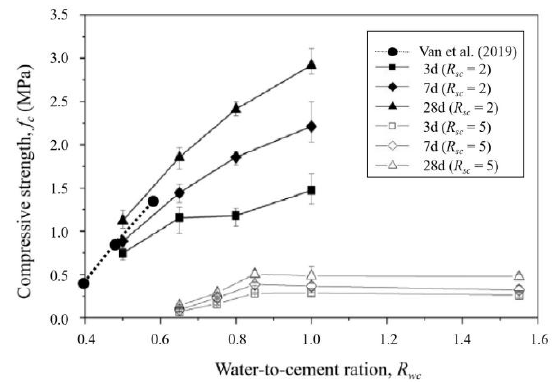
Figure 7. Development of compressive strength based on different sand-to-cement ratio ( R sc ).